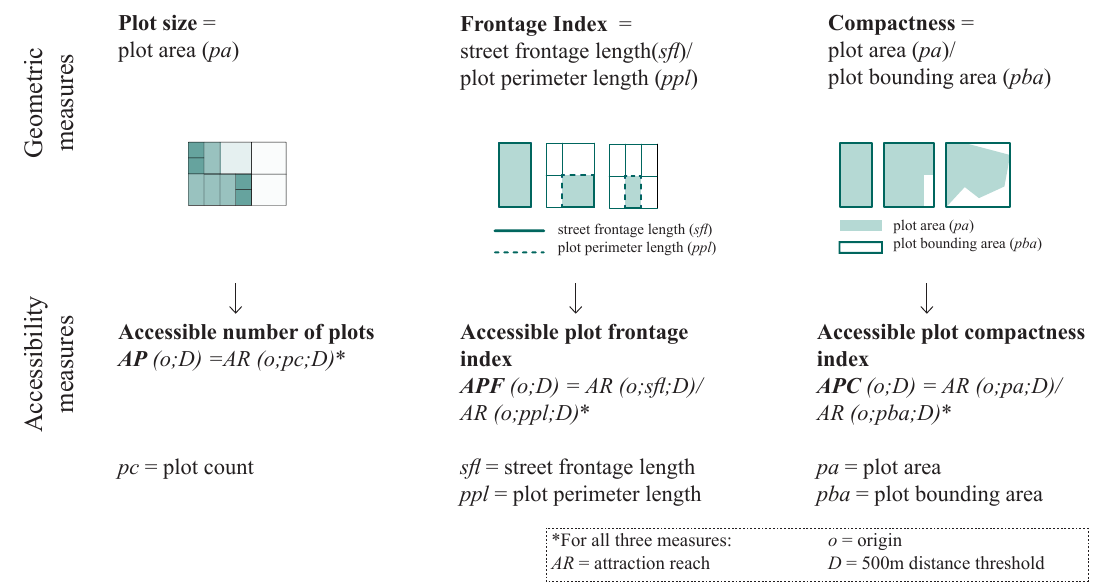
Figure 1. Overview of plot measures (for the detailed explanation of accessibility measures, see Appendix